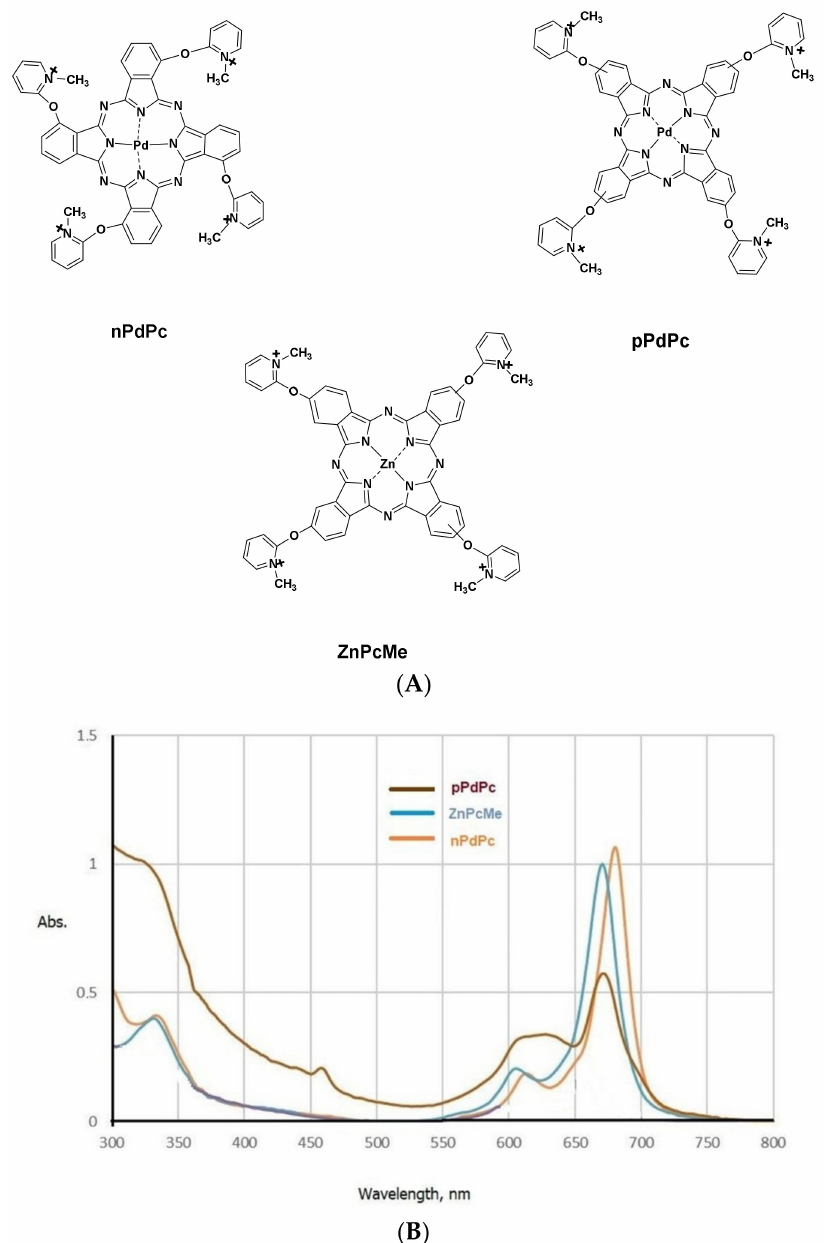
Figure 1. Phthalocyanine palladium (II) and zinc (II) complexes ( A ), and the absorption spectra in DMSO (10 − 5 M) ( B